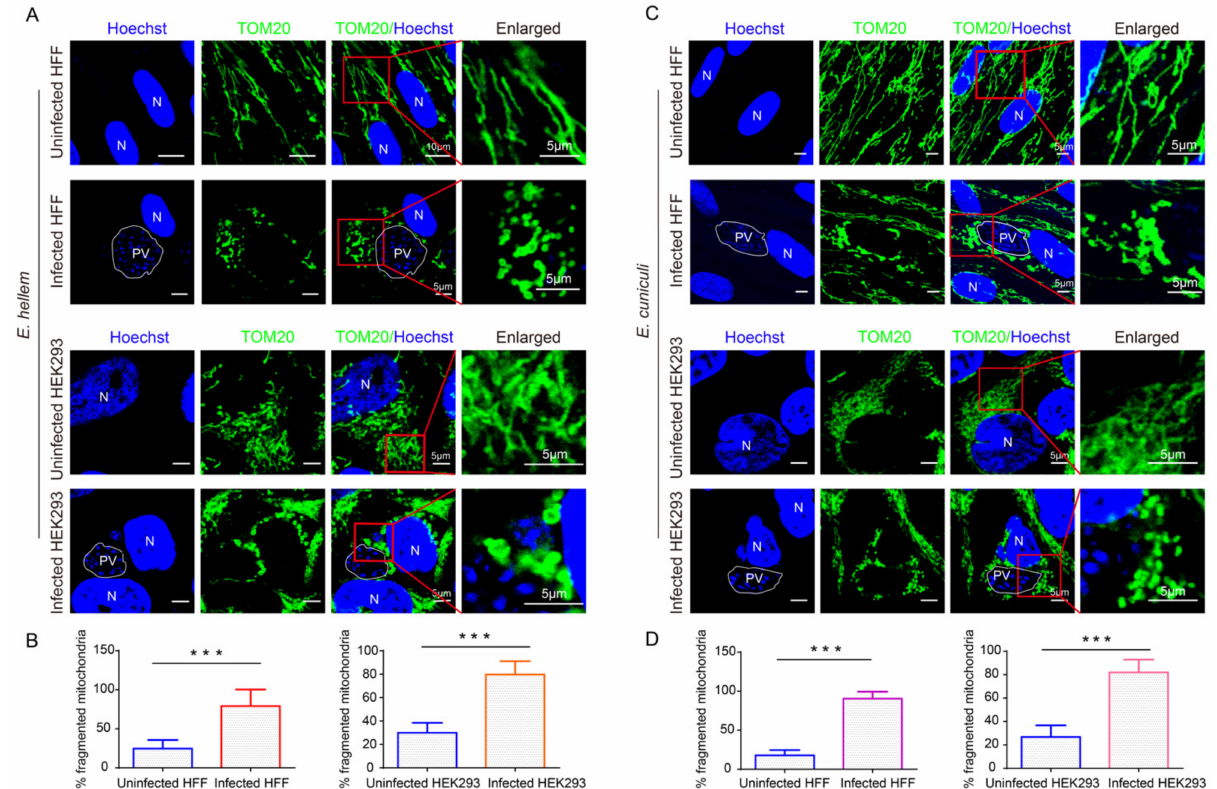
Figure 1. Analysis of host mitochondrial morphology in Encephalitozoon -infected cells at 48 hpi. ( A , C ) Mitochondrial morphology was detected in E. hellem - and E. cuniculi -infected HFF and HEK293 cells, respectively. Laser confocal shows nucleus labeled with Hoechst (blue). Mitochondria are labeled with the antibody against TOM20 (green). Bar, 5 µ m; PV, parasitophorous vacuole; N, nucleus. ( B ) The percentage of mitochondrial fragmentation in the E. hellem -infected HFF and HEK293 cells. ( D ) The percentage of mitochondrial fragmentation in the E. cuniculi -infected HFF and HEK293 cells. The punctate mitochondrion was identified as a fragmented one. A total of 100 cells were counted for three replicates with at least 30 cells for each replicate. *** p <